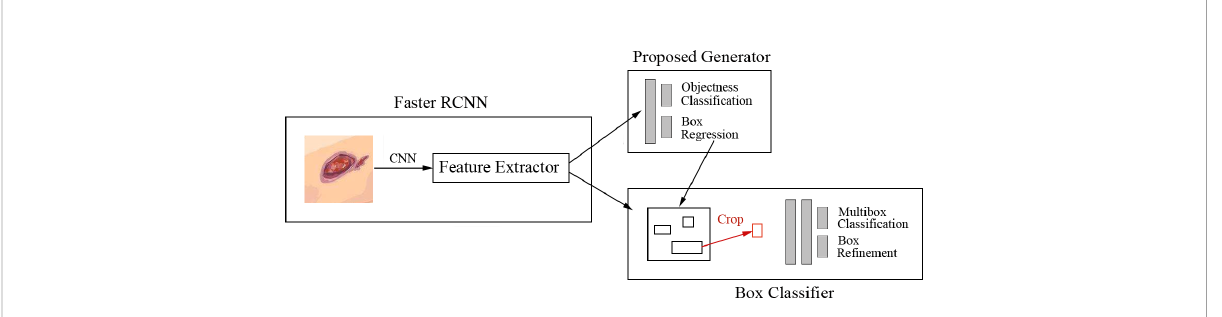
FIGURE 6 Faster R-CNN for DFU architecture (8) The model includes three stages. In stage 1, features are extracted by the CNN. In stage 2, region proposals are generated and re fi ned by using the feature map extracted in stage 1. In stage 3, all the ROI boxes are classi fi ed and the bounding box regressor is used to re fi ne the location of ROI